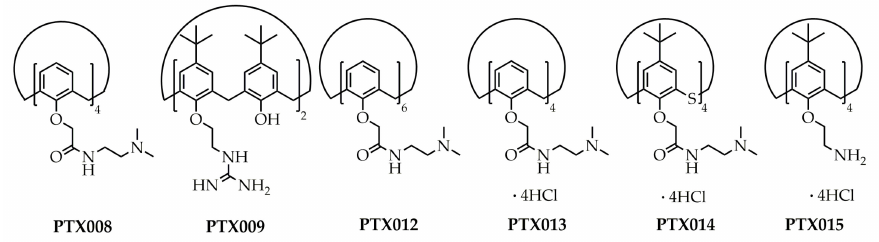
Figure 1. Calixarenes cytotoxic antitumor agents PTX008 – PTX015